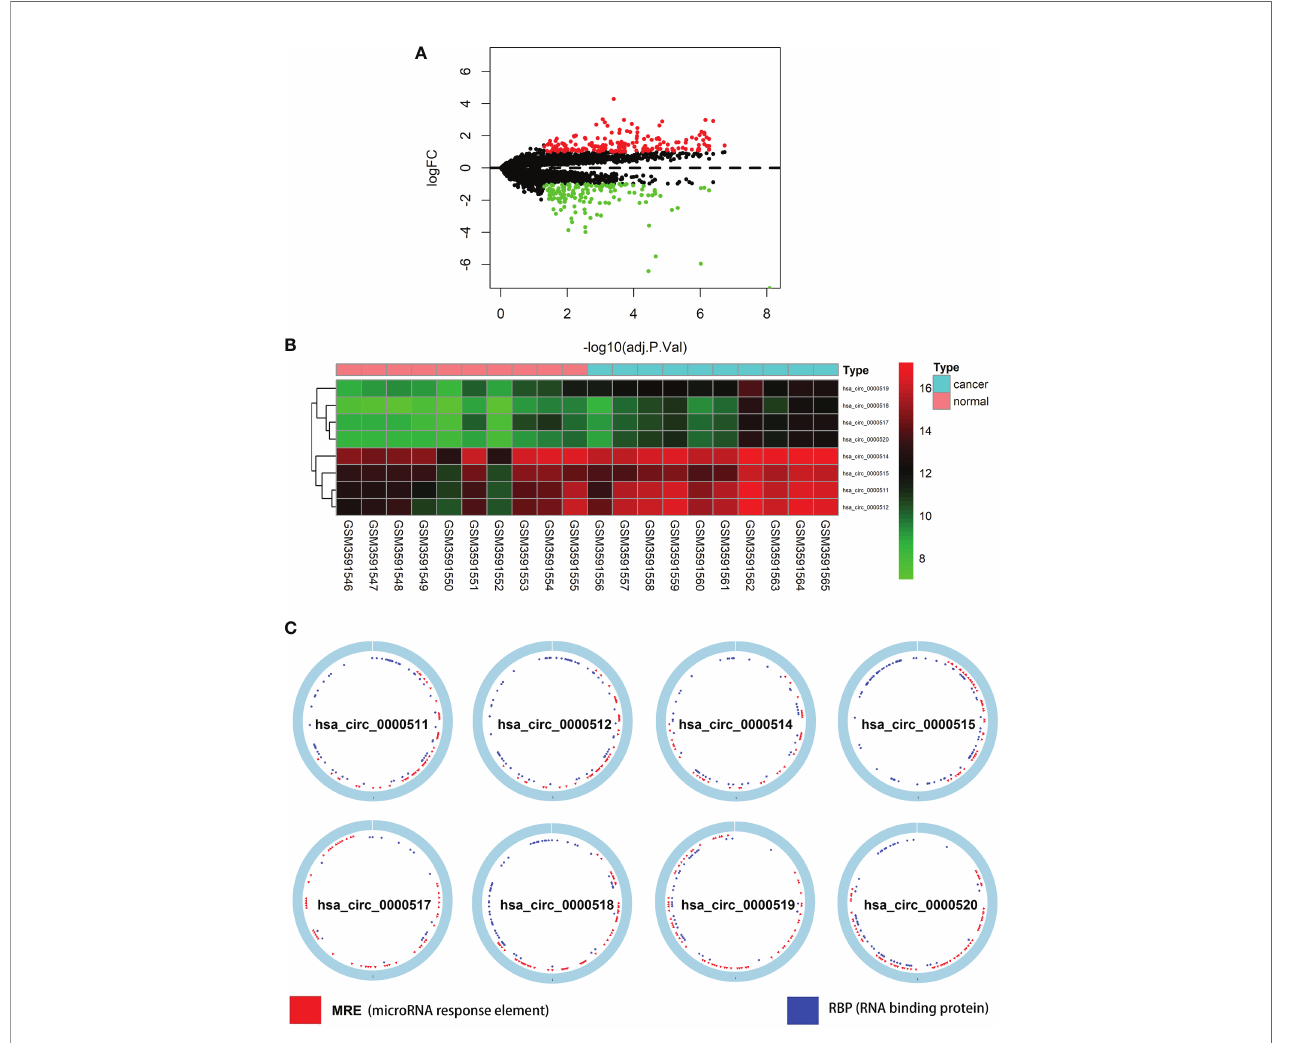
FIGURE 1 | Differentially expressed circular RNAs (circRNAs) from RPPH1 in colorectal cancer (CRC). (A) Volcano plots for differentially expressed circRNAs (DEcircRNAs) in CRC from the GSE126094 dataset. (B) Heatmap of the eight differentially expressed circRNAs from the RPPH1 gene. (C) Interaction patterns of the eight circRNAs based on